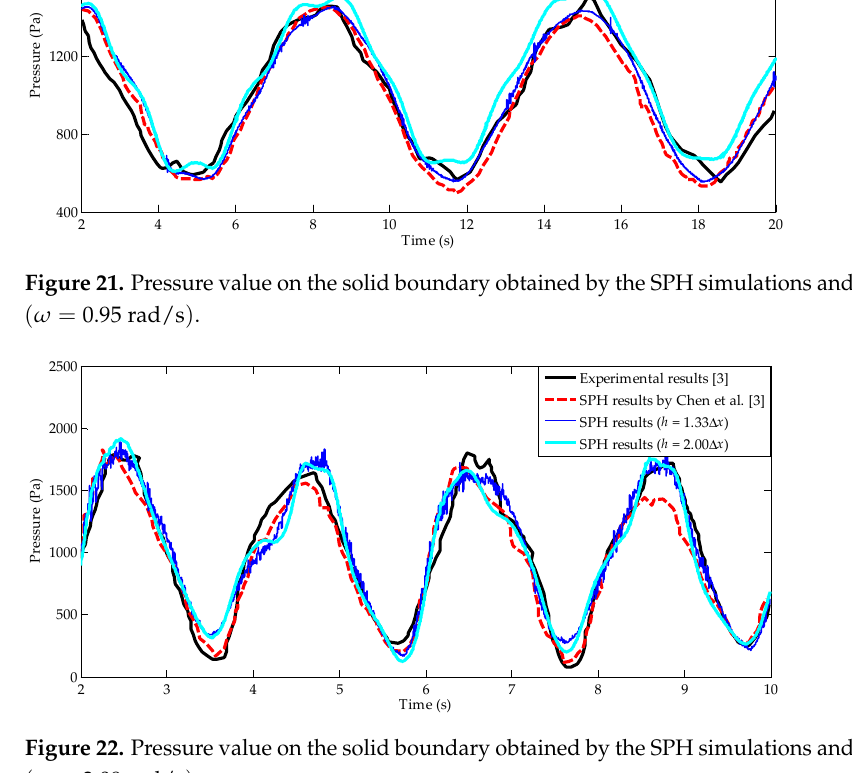
Figure 22. Pressure value on the solid boundary obtained by the SPH simulations and the experiment ( ω = 3.09 rad/s ) .